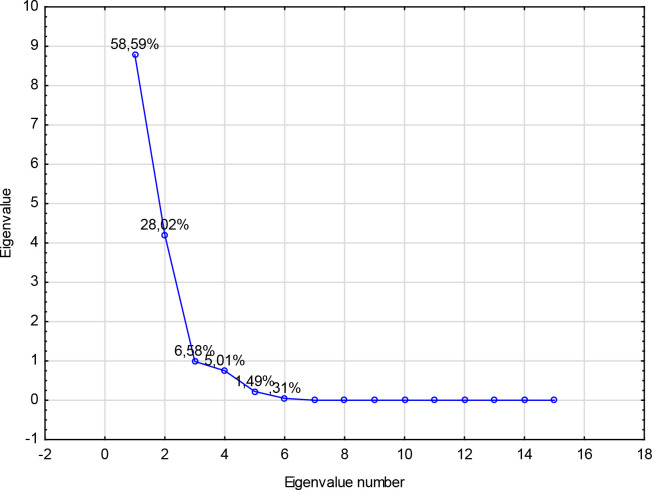
Scree plot and percentage of total variance accounted for by each factor for principal component analysis.